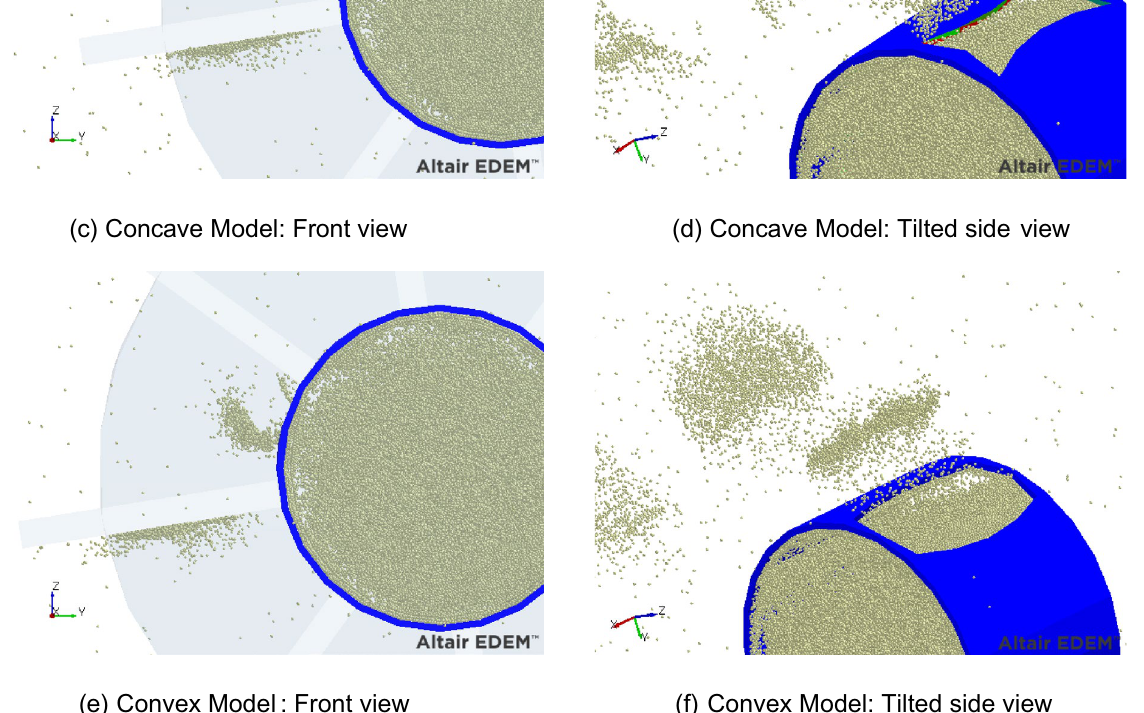
Figure 8. Spatial distribution of shot ball near control cage (Left column: before impact by blade and Right column: after impact by blade, deleted for easy view) (EDEM Academic ver. 2021, https:// www. altair. co. kr/